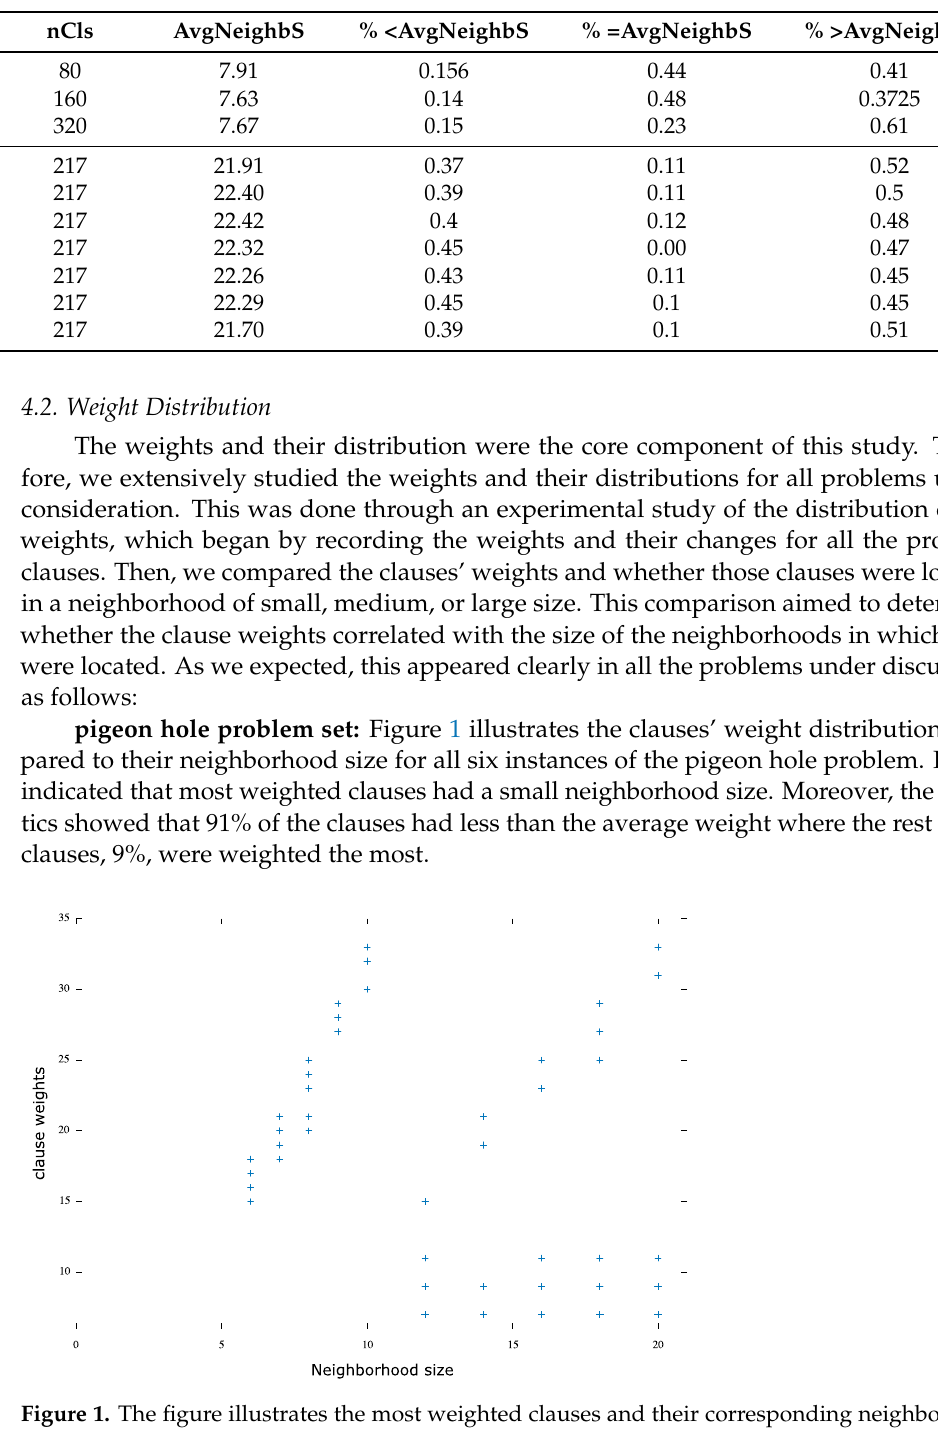
size for the pigeon hole problem set (six instances), where the overall average of the neighborhood size is ≈